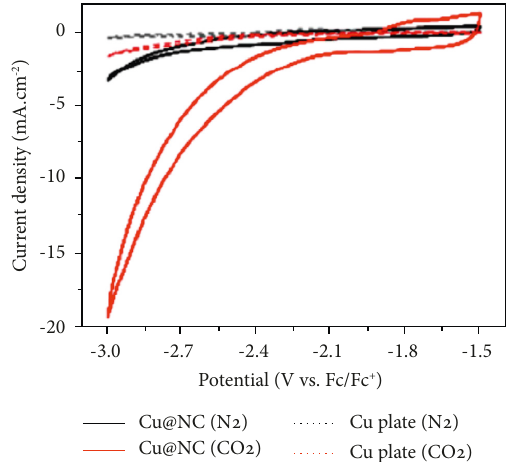
Figure 6: Cyclic voltammograms obtained with the Cu@NC and polycrystalline in N 2 - or CO 2 -saturated DMF (0.1 M Bu 4 NPF 6 ) solutions at a scan rate of 100mV · s1 from [62] under the terms of